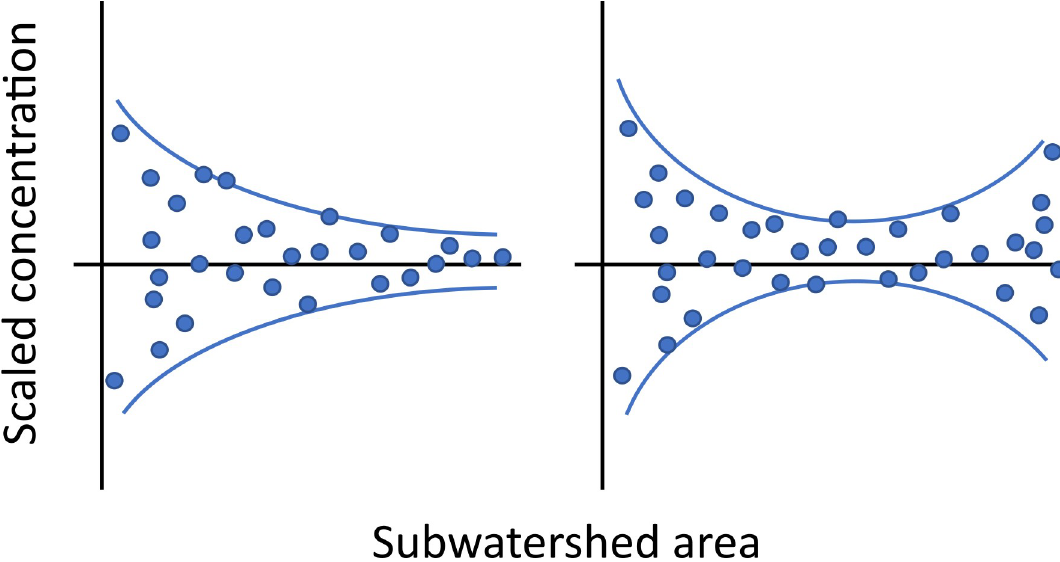
Fig 3. Theoretical diagram of spatial variability collapse (left) and spatial variability pattern observed in Utah Lake watershed (right).